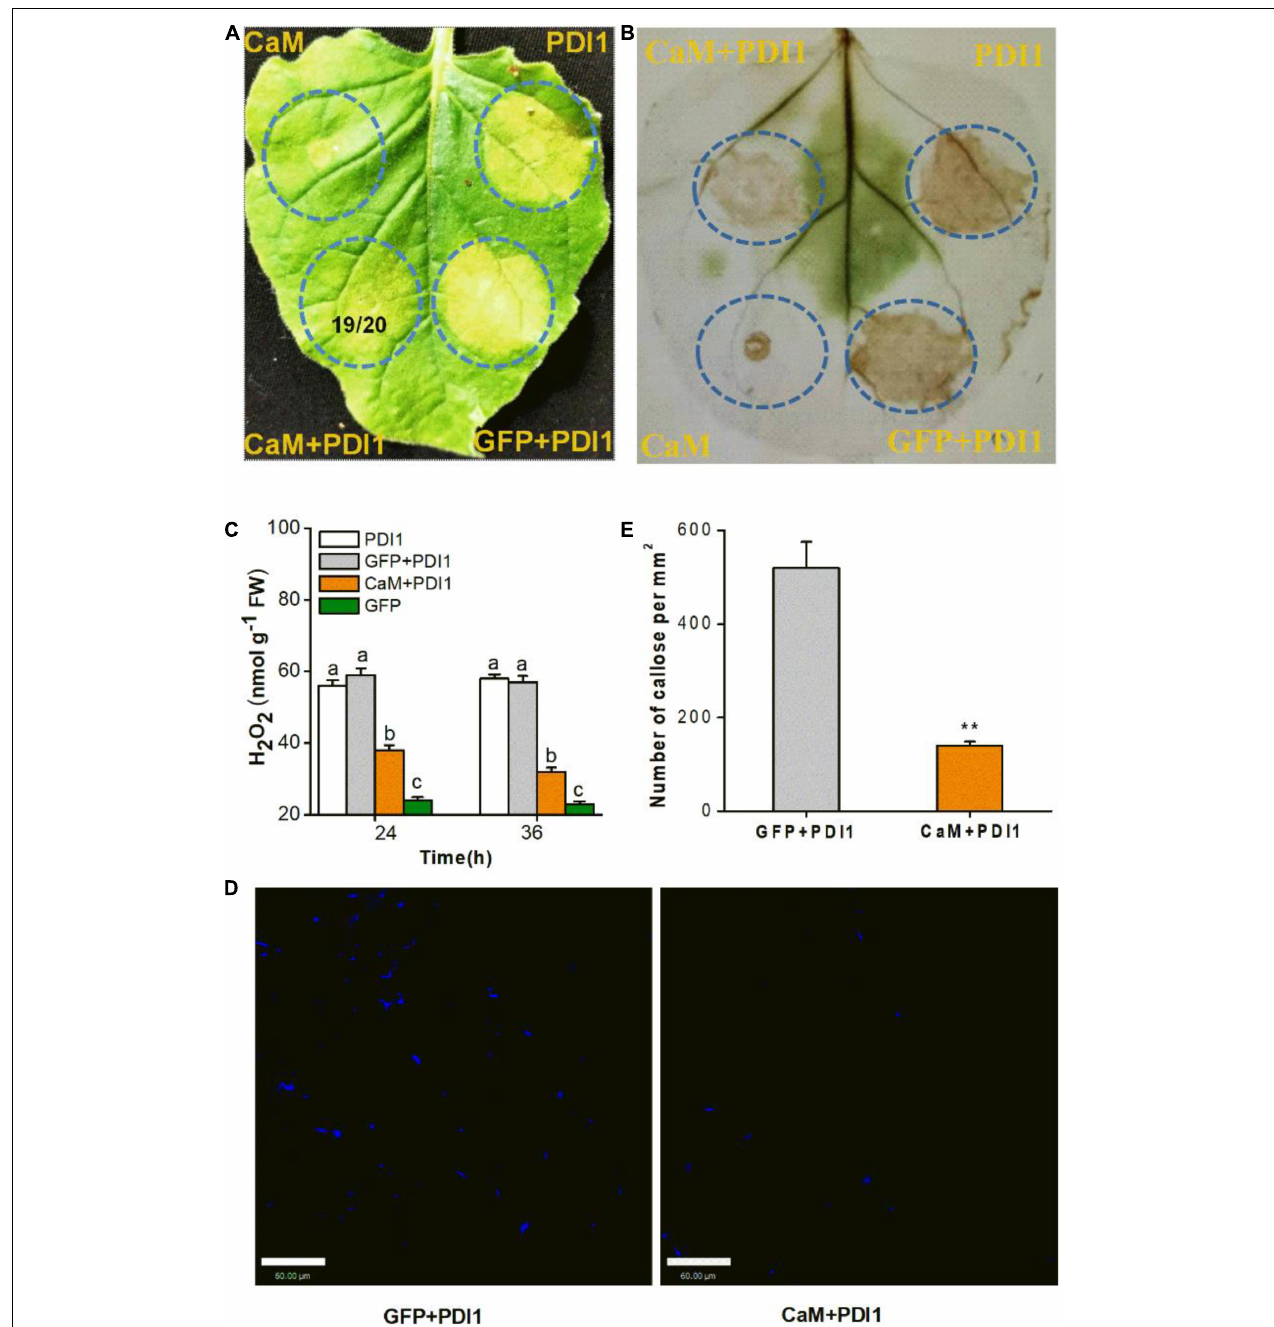
FIGURE 5 | Transient CaM expression suppresses cell death, H 2 O 2 accumulation, and callose deposition in Nicotiana benthamiana leaves. (A) LsPDI1-induced cell death was observed in all leaf areas co-expressing GFP and LsPDI1. A ratio of 19/20 in the circle of representative leaf indicates cell death reduction in 19 leaf areas co-expressing CaM and LsPDI1 relative to 20 experimental leaves. N. benthamiana leaves were infiltrated with A. tumefaciens harboring GFP or CaM at 24 h before LsPDI1 expression in the same region. Experiment was repeated on 20 leaves. PDI1 indicates the SBPH salivary elicitor LsPDI1. (B) Mitigation of LsPDI1-triggered H 2 O 2 accumulation in N. benthamiana leaves by CaM and LsPDI1 co-expression. After DAB staining and decolorization, brown color intensity and area were commensurate with H 2 O 2 level. LsPDI1-induced H 2 O 2 accumulation apparent in leaf areas co-expressing GFP and LsPDI1. (C) Mean levels + SE ( n = 6) of H 2 O 2 in infiltrated N. benthamiana leaves receiving foregoing treatments. Experiment was repeated six times with 0.1 g infiltrated areas combined as a single sample. Different letters indicate significant difference among treatments ( P < 0.05; one-way ANOVA followed by Duncan’s multiple range test). (D) Representative images of callose deposition in N. benthamiana leaves. Aniline blue staining of N. benthamiana leaves showing callose deposition (bright blue fluorescence) in areas transfected with GFP or CaM-GFP 24 h before LsPDI1 expression in the same region. Photographs were taken 72 h after infiltration. (E) Mean number of callose deposits + SE ( n = 20) per mm 2 . N. benthamiana leaves received same foregoing treatments. Asterisks indicate significant changes ( P < 0.01; Student’s t -tests). Bars = 60 µ m.